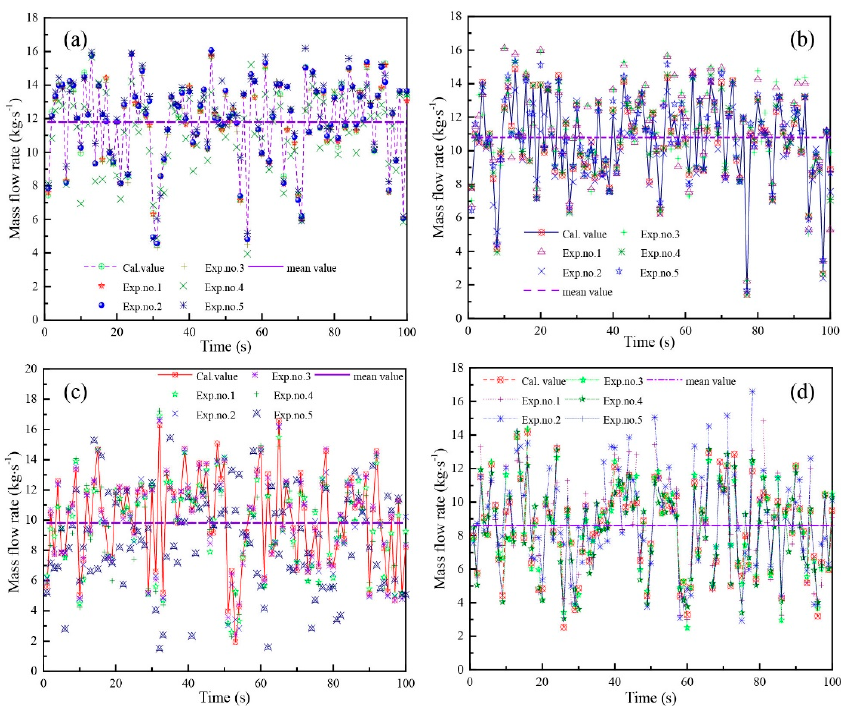
Figure 2. Comparison of the simulation and experimental sinter mass flow rate with different hopper half angles of ( a ) 30°, ( b ) 40°, ( c ) 50°, and ( d ) 60°.